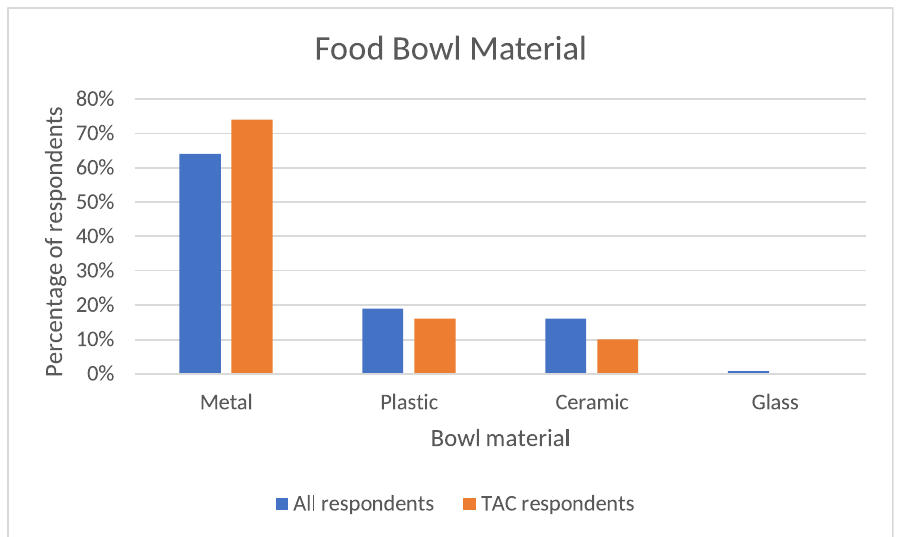
Fig 2. Food bowl material. Comparison of bowl type among all survey respondents and respondents of those participating in the APC assessment.